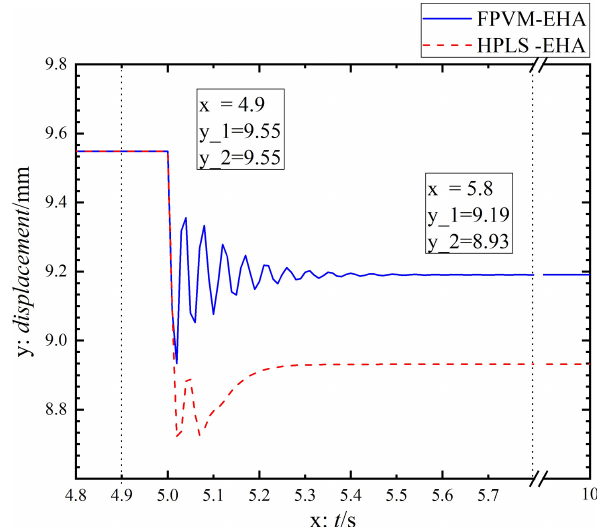
Figure 8. Contrast diagram of output torque of motor.